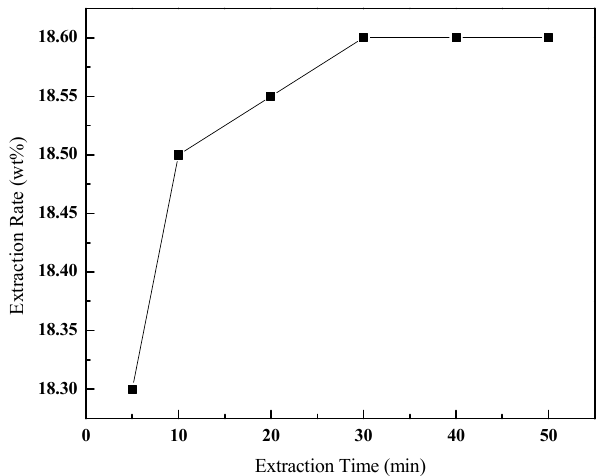
Figure 7. Effect of the extraction time on the extraction rate of Figure 7. E ff ect of the extraction time on the extraction rate of bitumen.